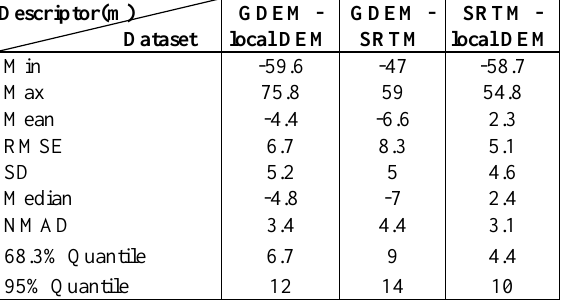
Table 3. The results of usual and robust measures for accuracy assessment of SRTM, GDEM and local DEM